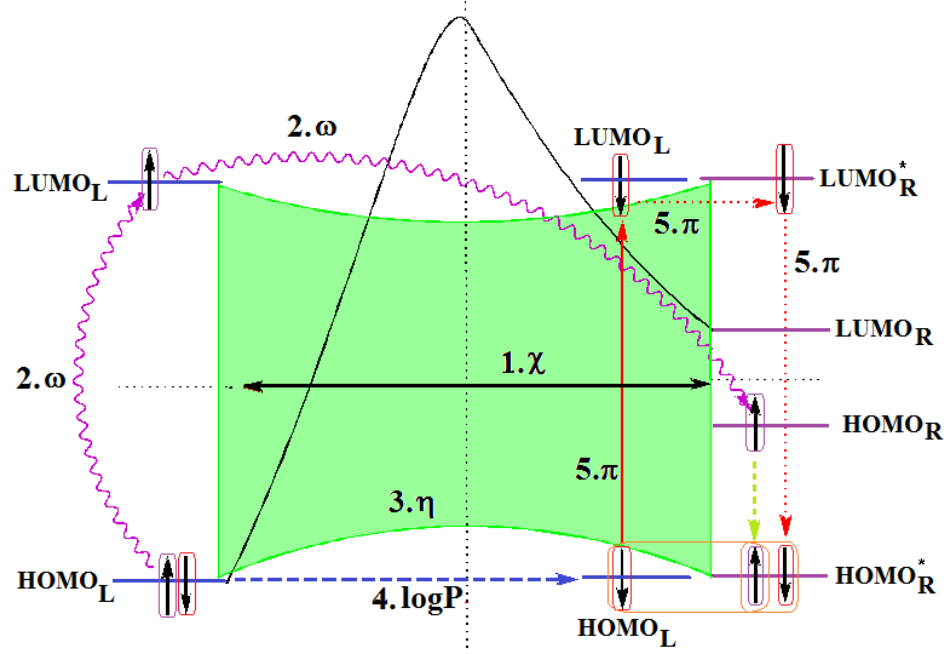
Figure 4. Representation of mechanistic molecular orbital interaction and bonding between the the uracil derivative compounds and HIV through binding the SMILES (essentially the BraS) molecule (the ligand, L) with the molecular pocket of the receptor (R) site, see the stages ( D ) & ( E ) of Figure 3, through variational principles of chemical reactivity of 1. electronegativity ( χ ), 2. electrophilicity ( ω ), 3. chemical hardness ( η ), 4. lipophilicity (logP) and 5. chemical power ( π ), according with the Spectral-QSAR analysis of equations